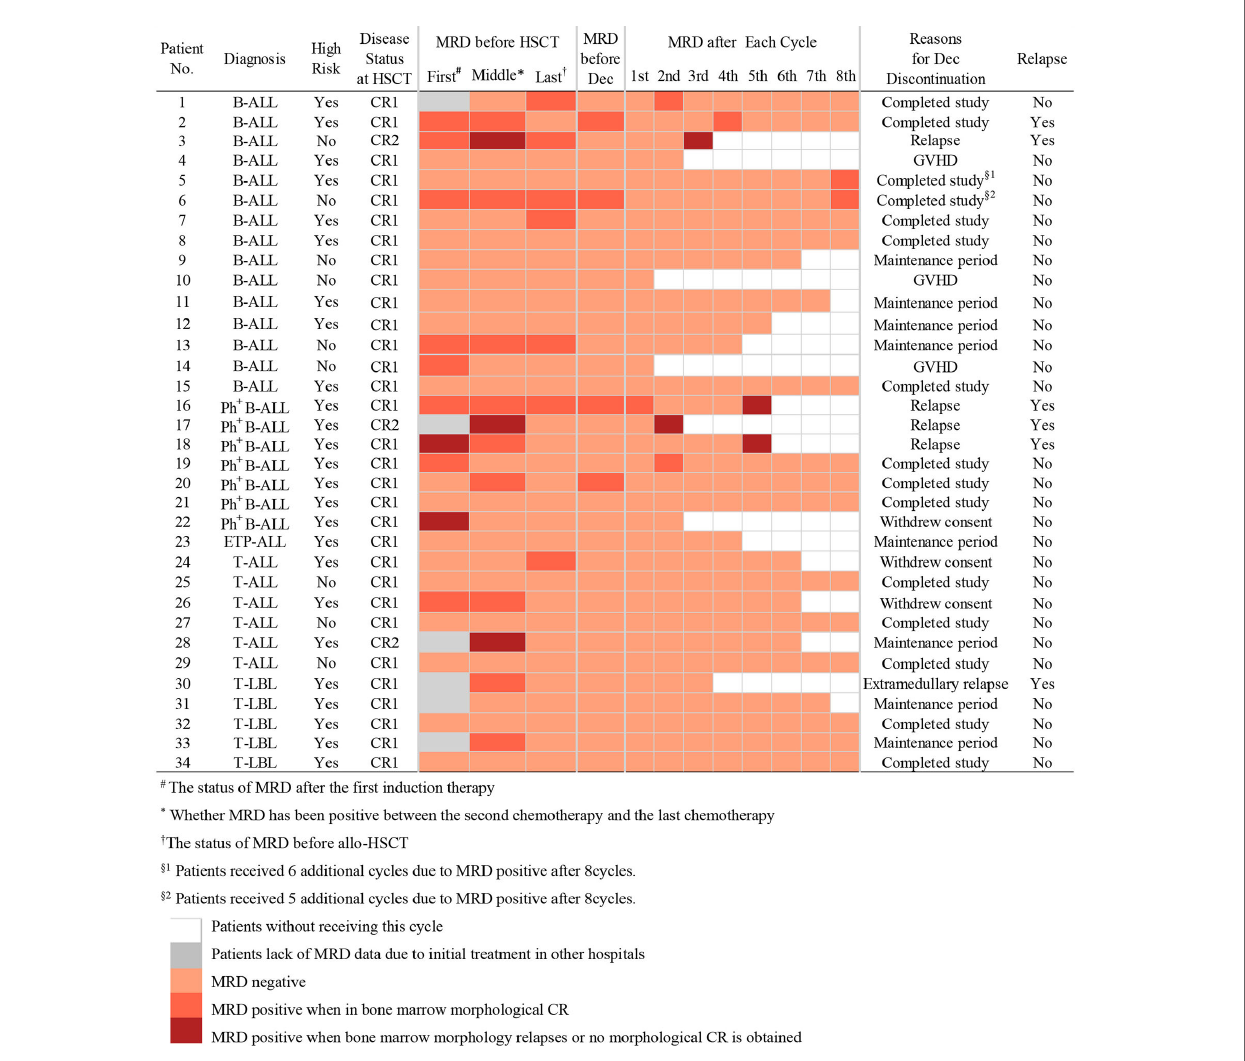
FIGURE 1 | Changes in MDR and decitabine exposure in